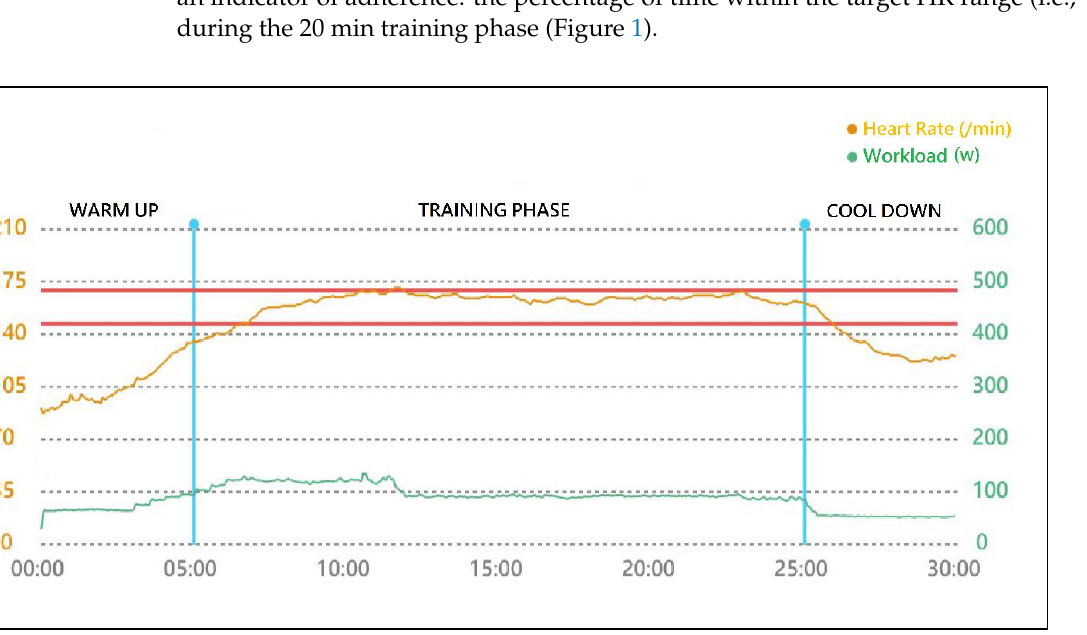
Figure 1. Demonstration of a training-intensity adherence diagram generated by the ICTS. The 2 horizontal red lines indicate the 60% and 80% HRR (147 and 170 bpm, respectively) of this partici- pant according to a predetermined target HR. During the 20 min training phase, the HR was kept within the target range 91.1% of the